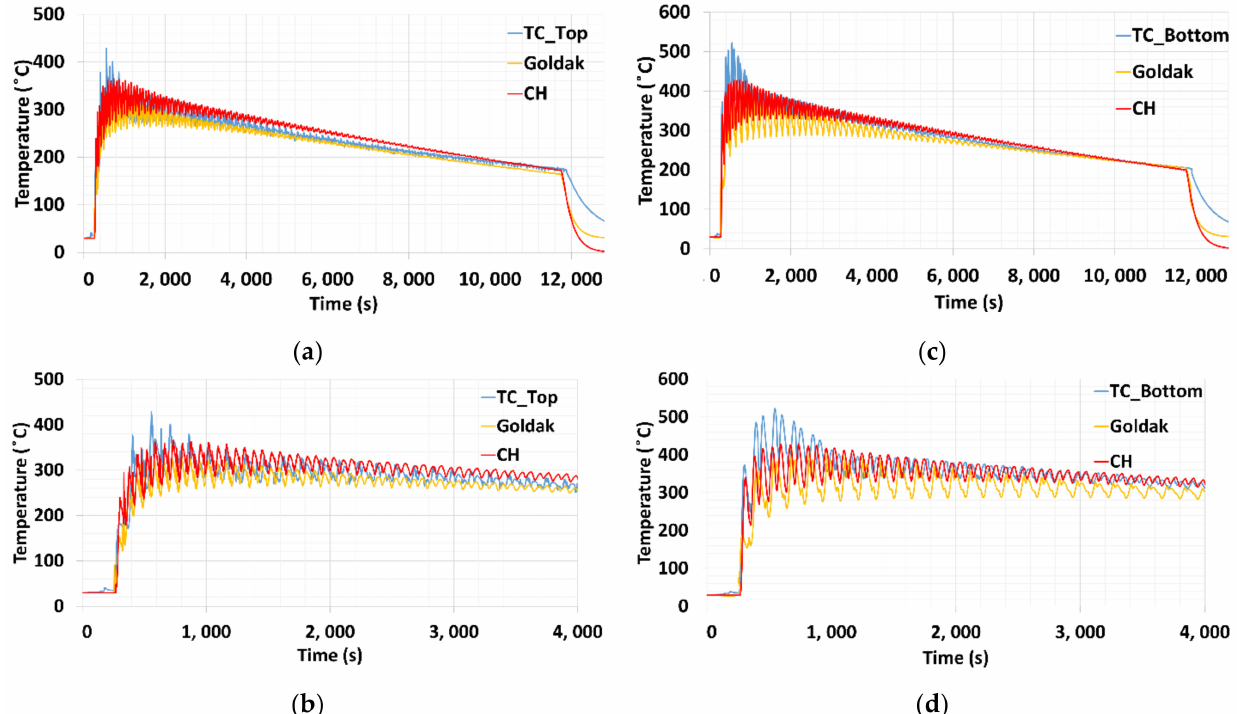
Figure 15. Temperature distribution on the base plate measurements ( a ) Top region ( b ) Detailed plot for the top surface ( c ) Bottom region ( d ) Detailed plot for the bottom